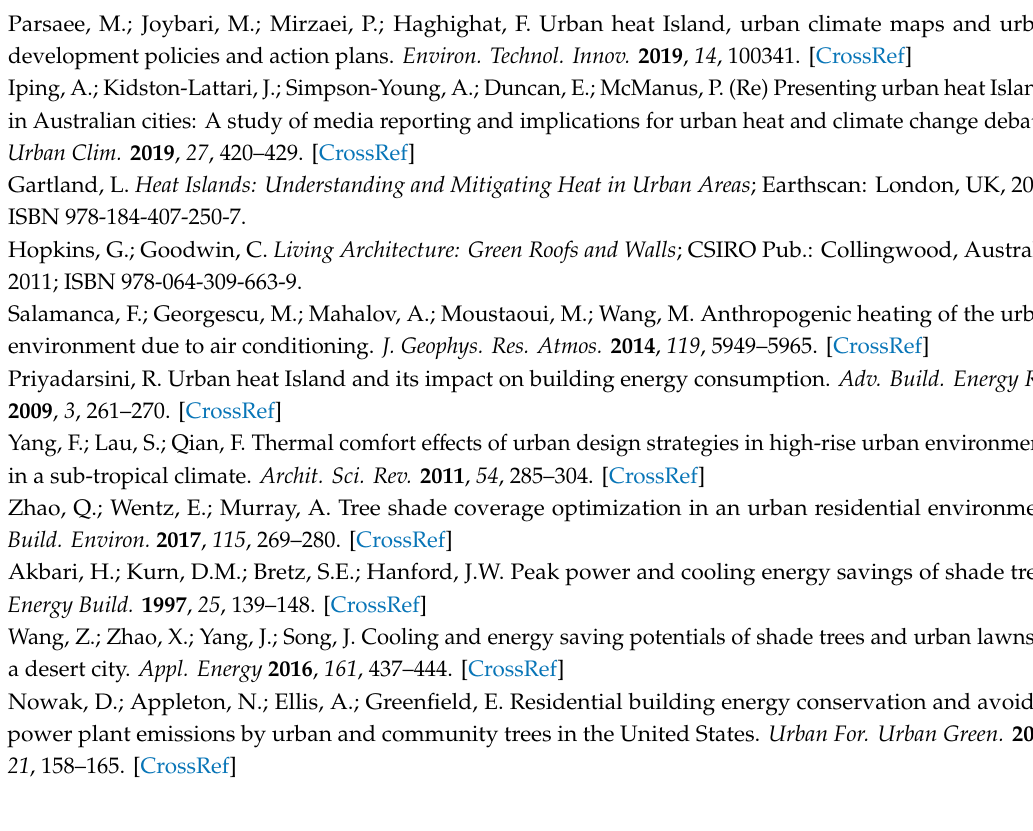
Table S1: Tree species with their mean, minimum and maximum air temperature in the shade (TAS), in the sun (TASL) and the di ff erential between these ( ∆ TA). Table S2: Mean, minimum and maximum TAS, TASL and ∆ TA recorded in bare soil, grass, bark mulch, pavers and bitumen. Table S3: Tree species with their mean, minimum and maximum shaded surface temperature (TSS), sunlit surface temperature (TSL) and surface temperature di ff erential ( ∆ TS). Table S4: Tree species with their mean, minimum and maximum globe temperature in the shade (GTS), in the sunlight (GTSL) and the di ff erential between the them ( ∆ TG). Author Contributions: K.T.U.N. collected and analysed the data and wrote the draft manuscript. P.S.